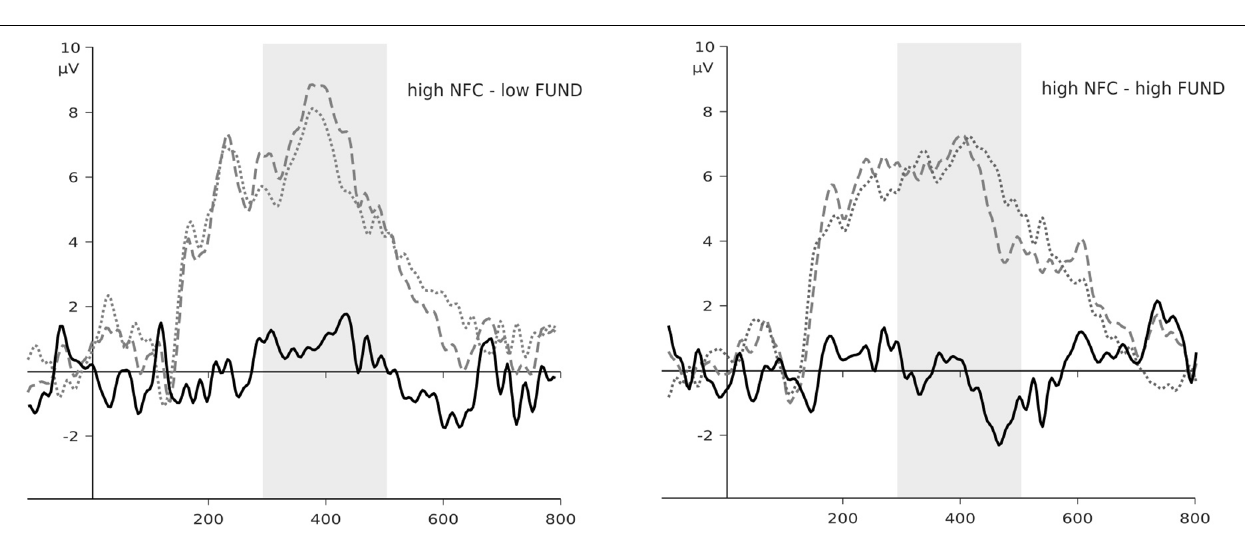
FIGURE 2 | Event-related potential (ERP) plots for high NFC group and median-split of fundamentalism scores averaged from the POz, Pz, CPz electrodes. The N400 component is defined as a difference (black solid line) between average activity within the 300–500 ms window for error-related (dashed lines) minus neutral (dotted lines) words. Gray polygons marks the time window of interests (300–500 ms), relative to words onset. Despite the absolute differences between values, the statistical significance was found only for the high NFC slope and not for the low NFC. Without these statistical parameters, the ERP plots may be misleading on a first sight. Moreover, the presented plots are provided only for illustrative purposes, and were created with median split of the variables. The results that are considered in the manuscript were computed using continuous